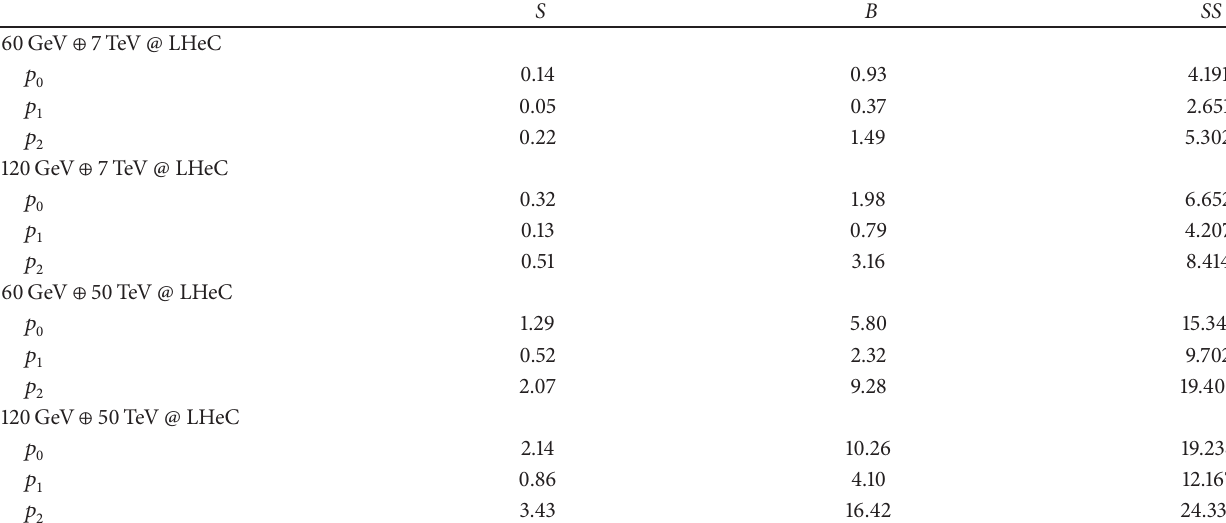
Table 2: Expected cross sections after all the selections for signal and backgrounds at the LHeC with integrated luminosity of 1000 fb −1 , 𝑏